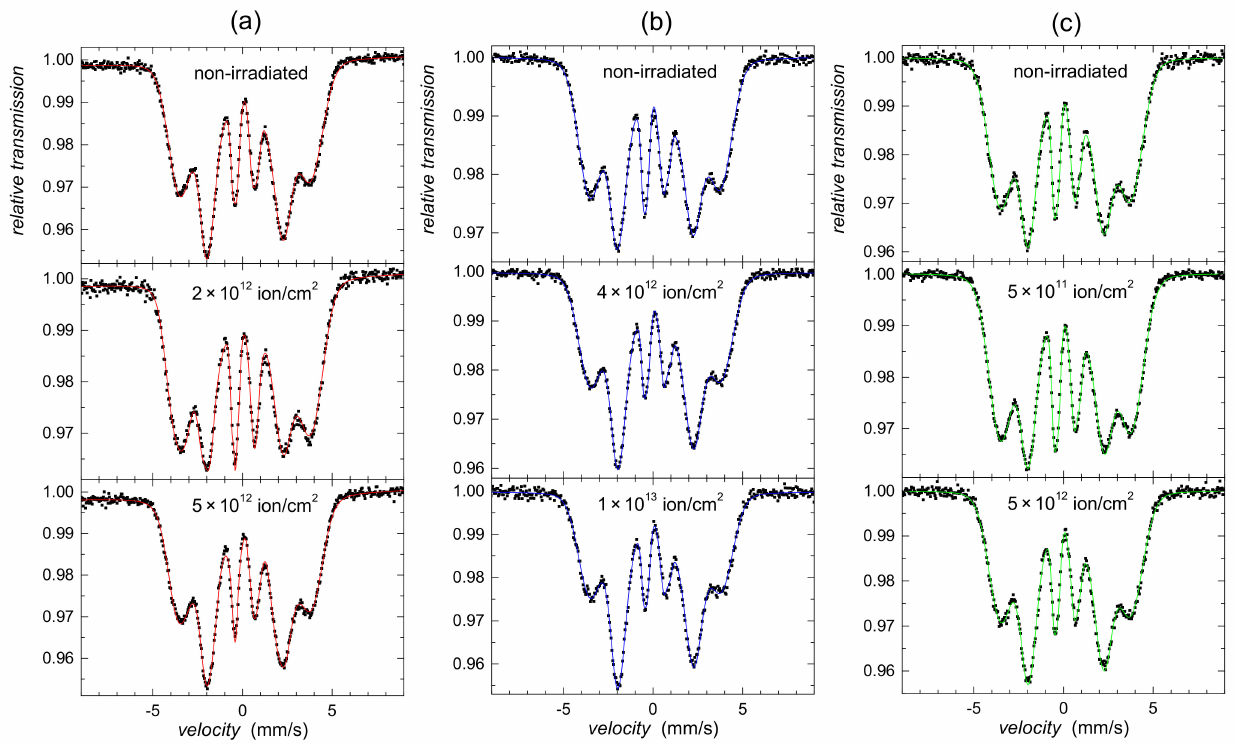
Figure 19. Mössbauer spectra of Fe 73 Cu 1 Nb 3 Si 16 B 7 amorphous metallic alloy recorded in transmission geometry after irradiation by: ( a ) 5.9 MeV/u 238 U ions (red); ( b ) 11.1 MeV/u 131 Xe ions (blue); ( c ) 11.1 MeV/u 197 Au ions (green) with the indicated fluences.